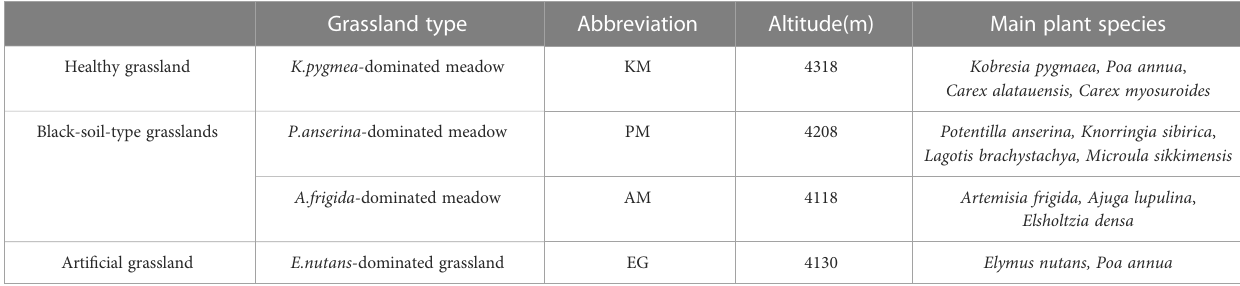
TABLE 1 Characteristics of sampling sites in the Three-River Headwaters